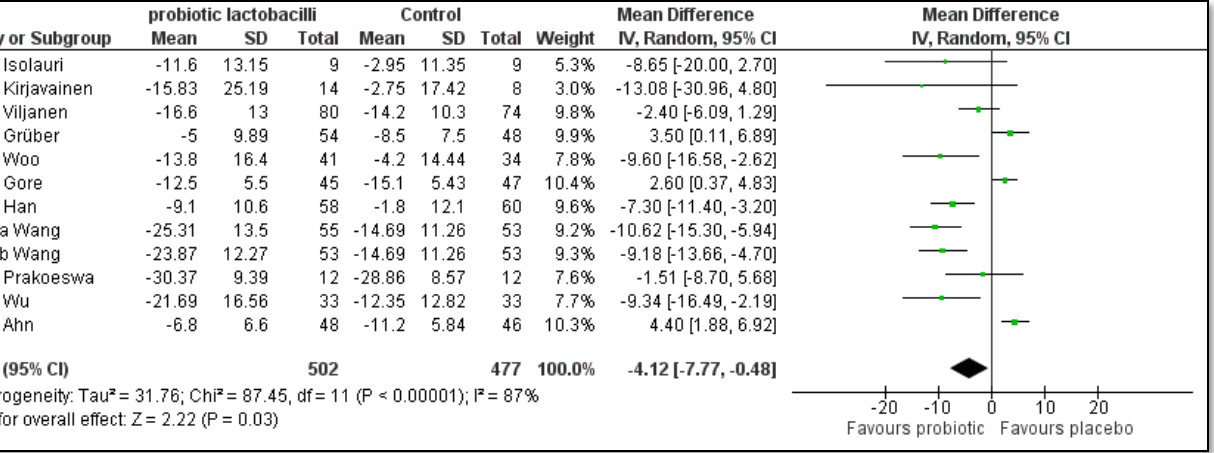
placebo on the SCORAD index change in children with moderate to severe AD [44,46,49].